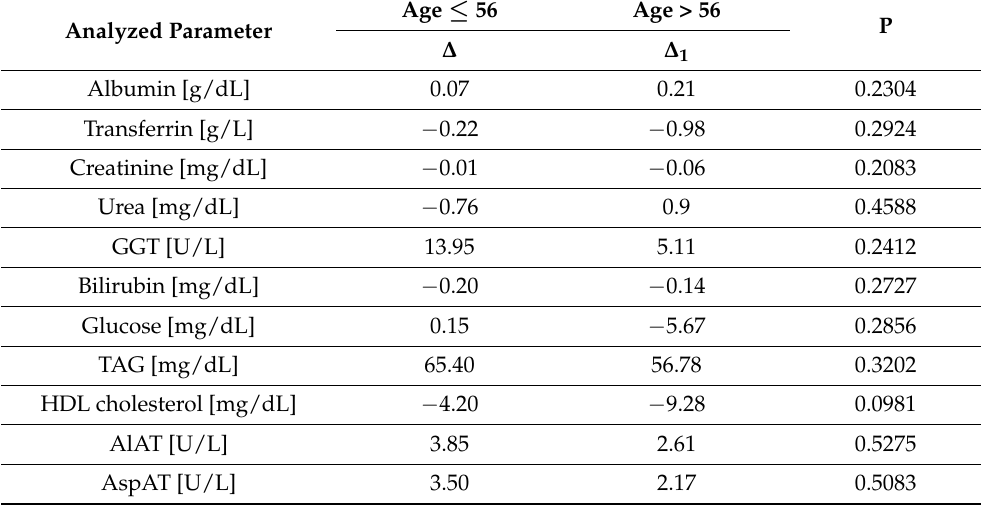
Table 8. Comparison of changes (before and after 6-week chemotherapy) for biochemical and anthropometric parameters depending on age in the matched supplemented